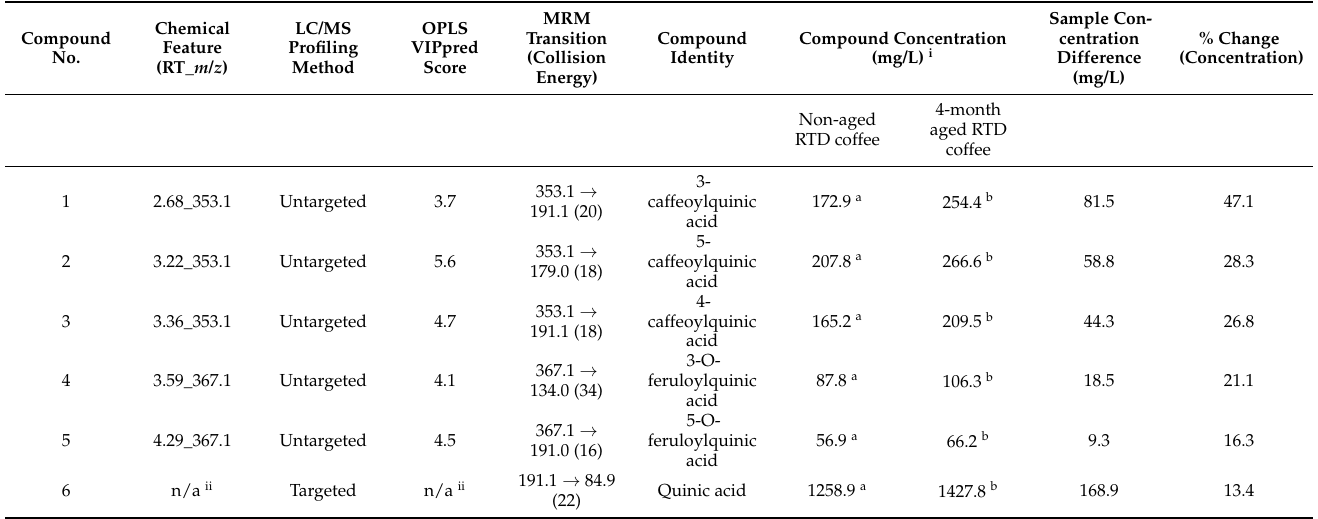
Table 2. Untargeted and targeted LC/MS compounds in nitrogen flushed Arabica RTD coffee during